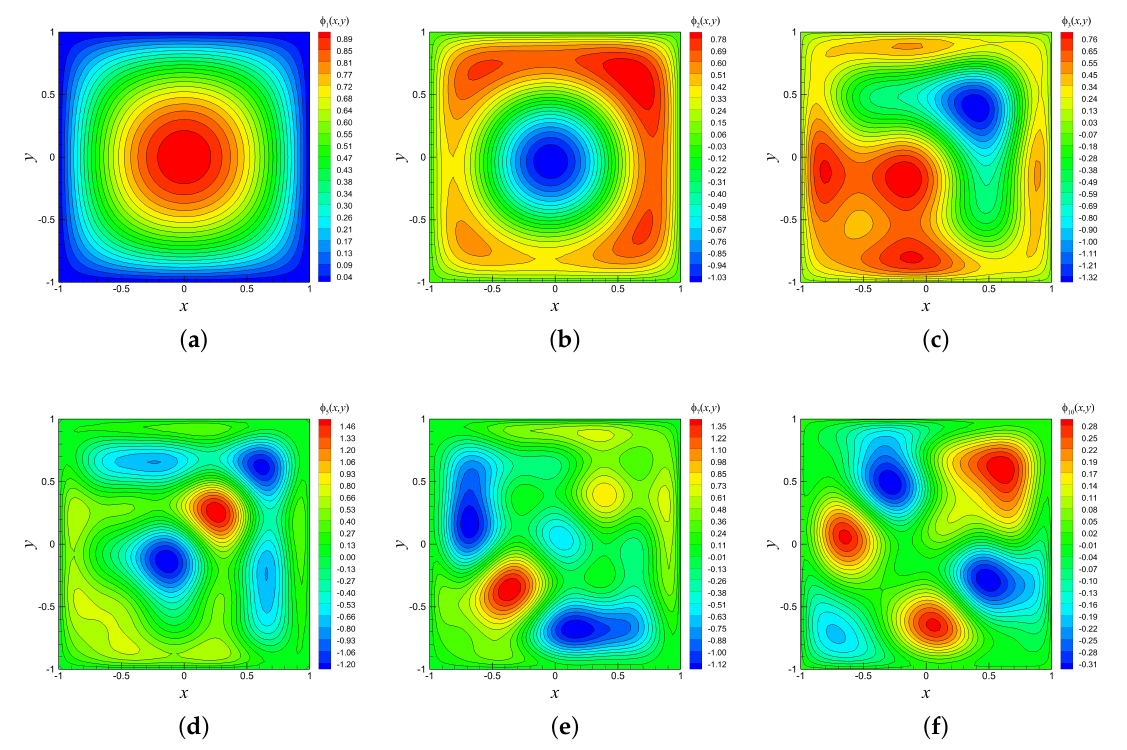
Figure 3. Contour plots of some illustrative proper orthogonal decomposition (POD) basis functions generated by the method of snapshots for the Poisson equation: ( a ) φ 1 ( x , y ) ; ( b ) φ 2 ( x , y ) ; ( c ) φ 3 ( x , y ) ; ( d ) φ 5 ( x , y ) ; ( e ) φ 7 ( x , y ) ; ( f ) φ 10 ( x , y )